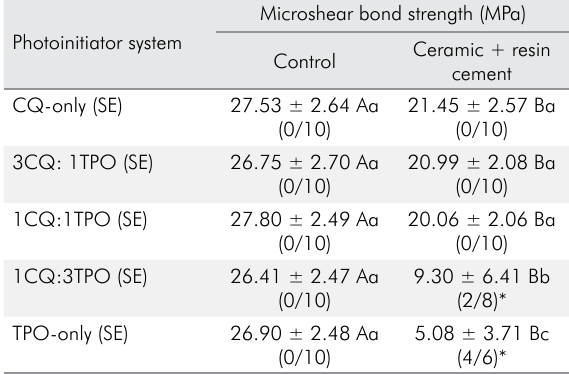
Table 4. Microshear bond strength means (± standard deviation) for ER experimental adhesive systems with and without interposed ceramic veneer and resin cement layer Photoinitiator system